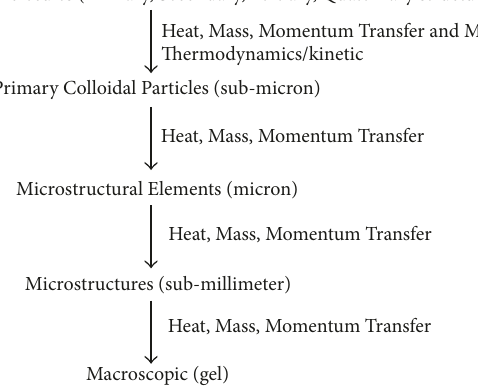
Figure 5: Mechanism of protein gel formation (adapted from Marangoni et al.